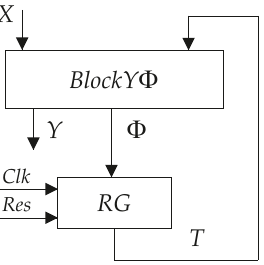
Figure 1. Structural diagram of FSM U 1 .